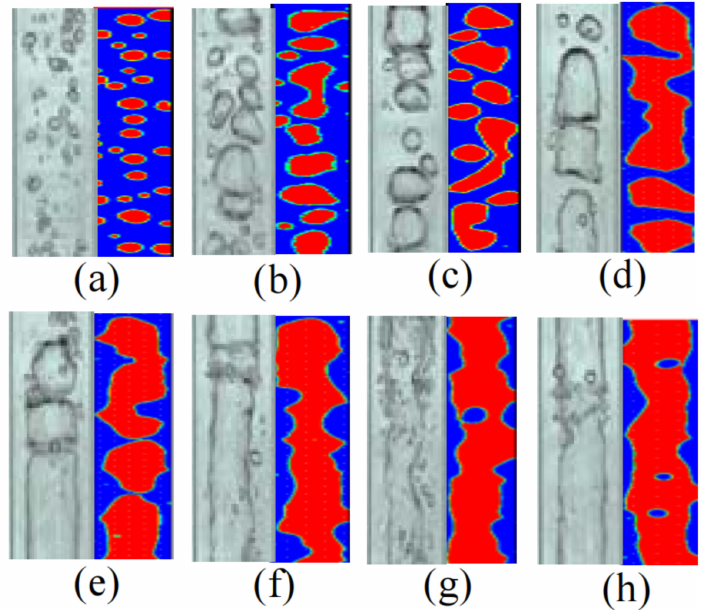
Figure 7. Effects of Nitrogen flow on two-phase flow pattern and model validation [18]. Reproduced with permission from Higher Education Press, 2019. ( a ) 10 lph, ( b ) 20 lph, ( c ) 30 lph ( d ) 40